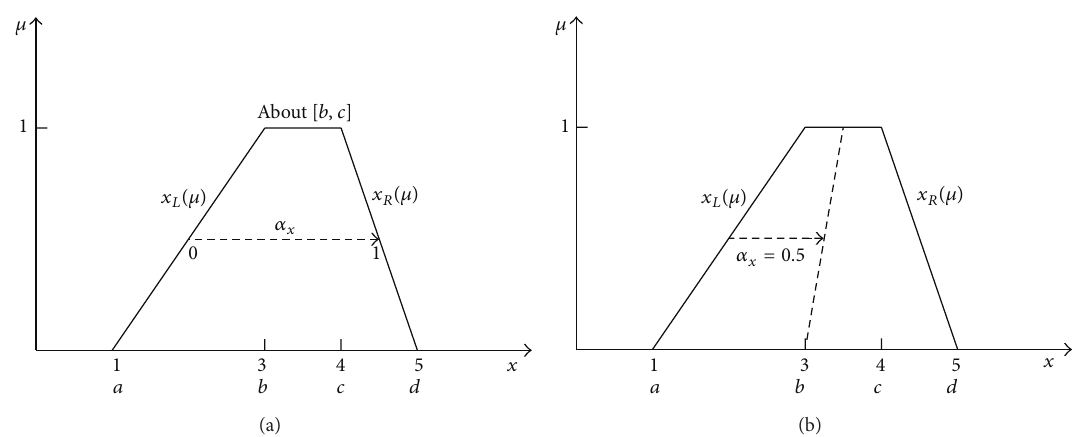
Figure 2: Visualization of the horizontal approach to fuzzy membership functions.